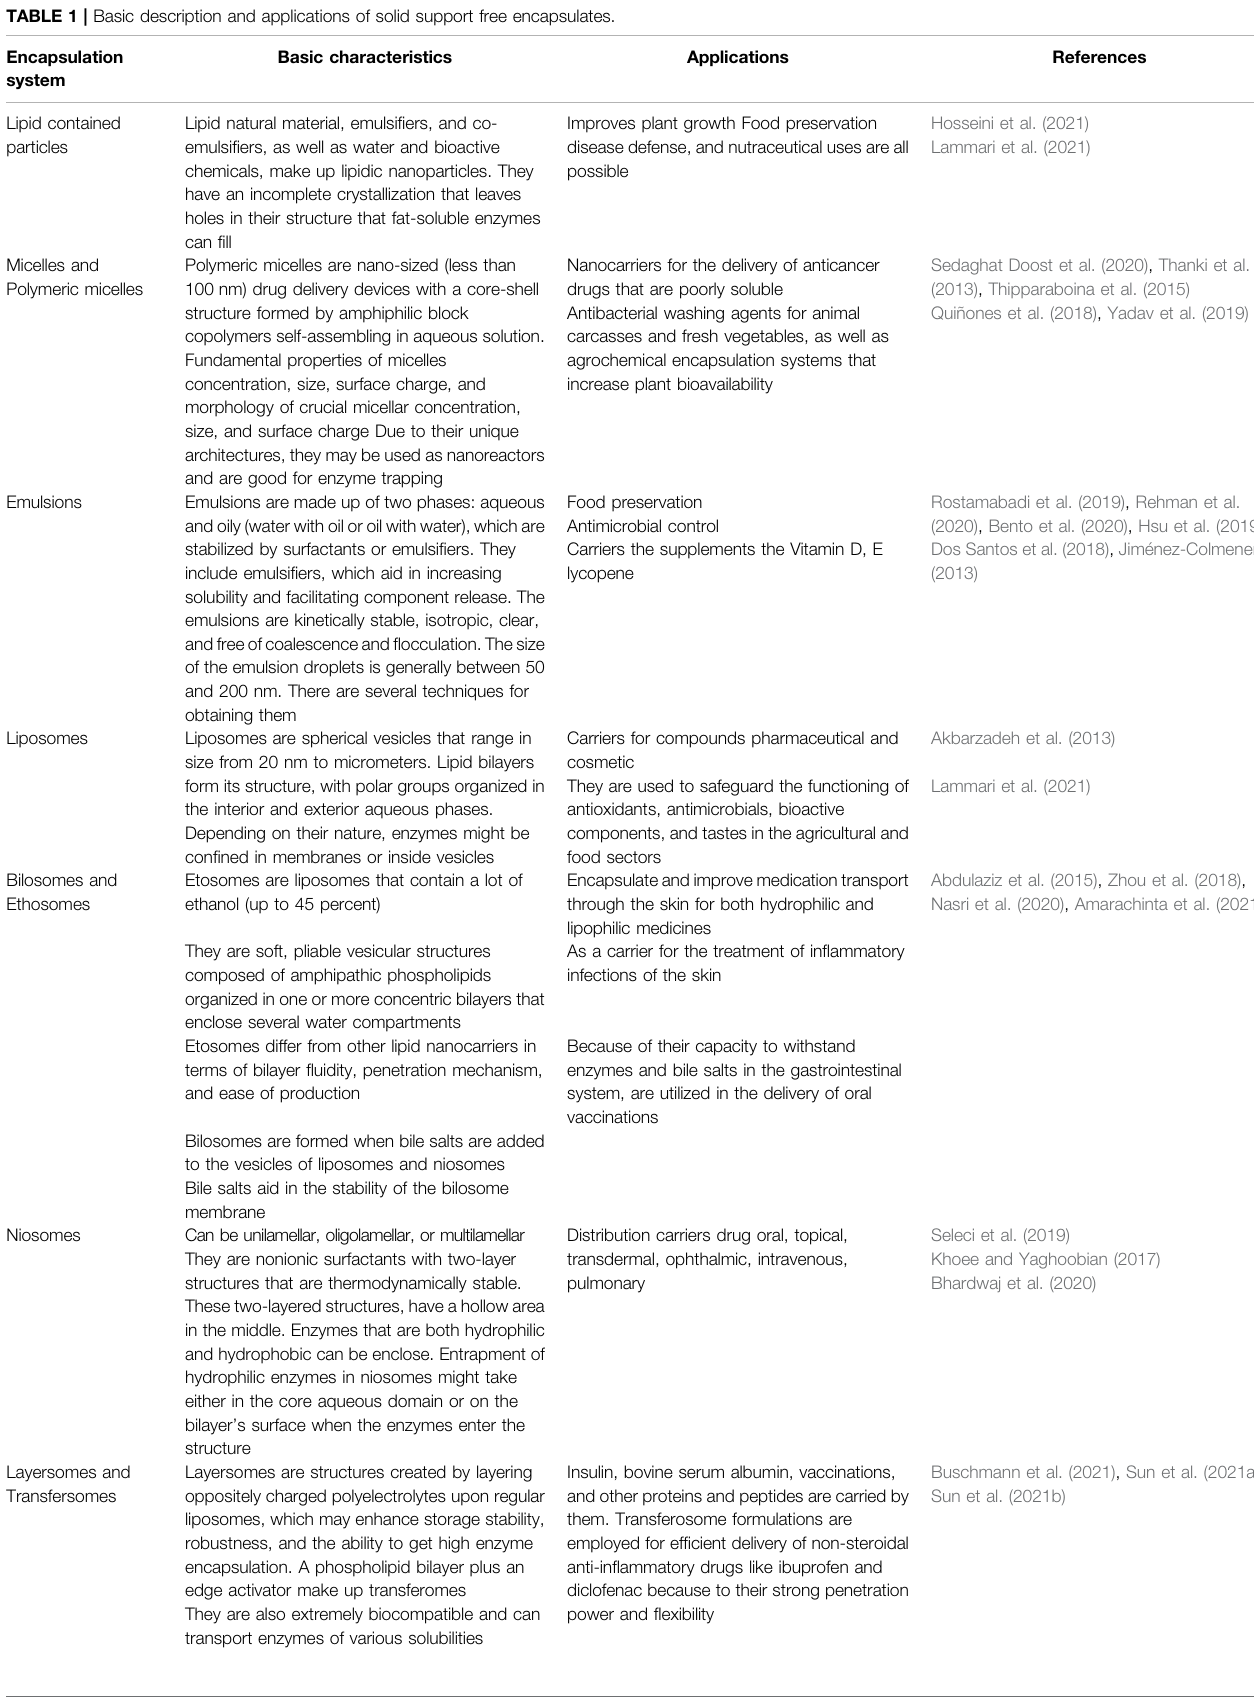
TABLE 1 | Basic description and applications of solid support free encapsulates. Encapsulation